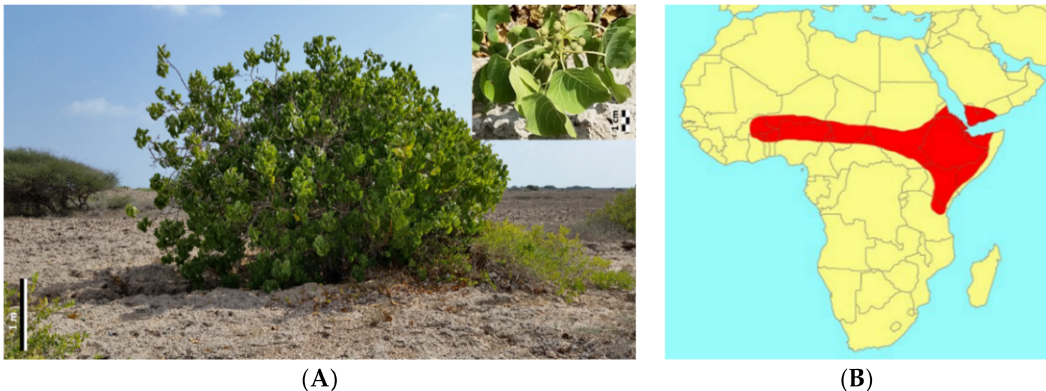
Figure 1. ( A ) Ficus populifolia Vahl. tree in its natural habitat. Photo by S. Alharbi from the Farasan Islands, the Red Sea (Saudi Arabia); ( B ) distribution map produced by Simon van Noort (Iziko Museums of South Africa), www.figweb.org (accessed on 14 February